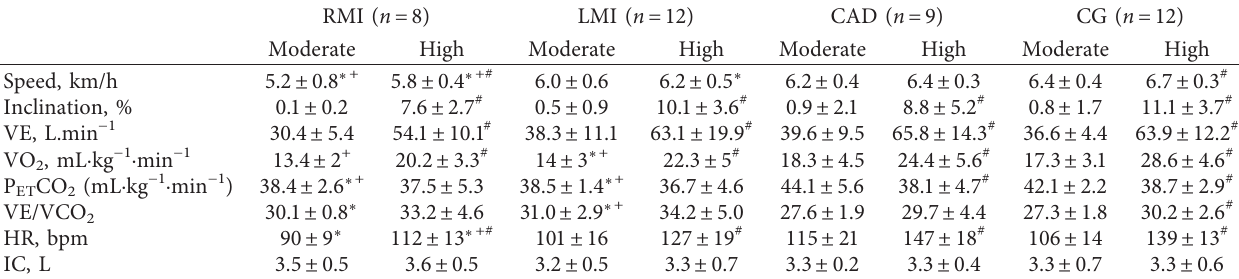
Table 4: Constant workload exercise test variables (moderate and high intensity) of groups.